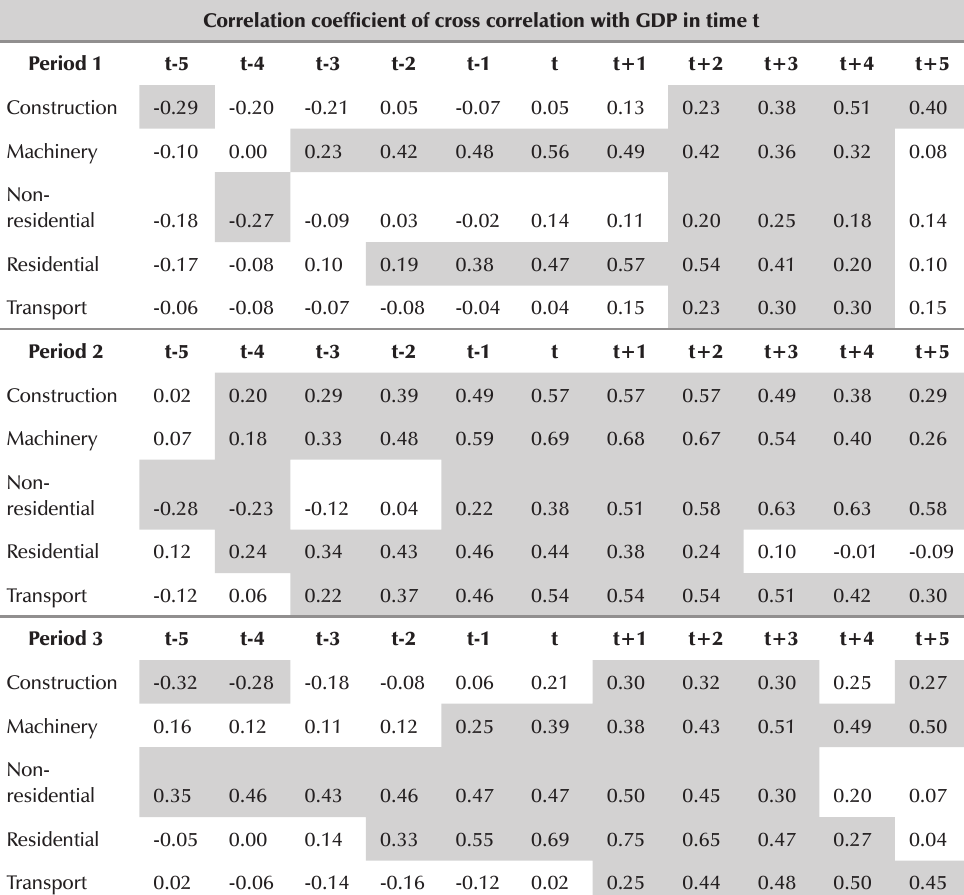
Correlation coefficients of the asset components of